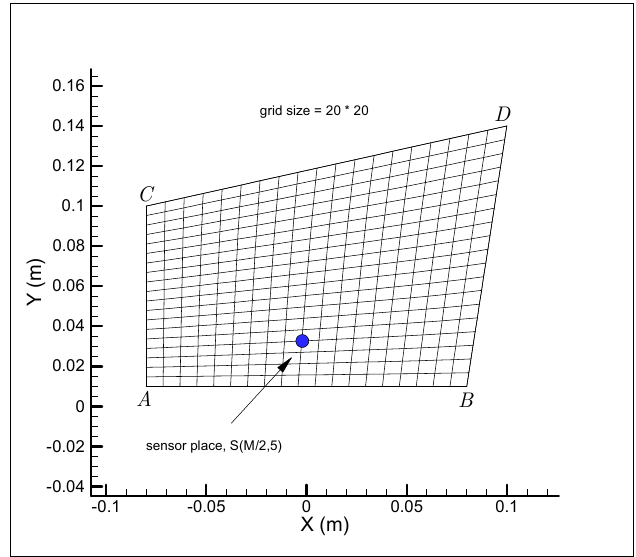
M ( M ,5 ) , used to measure the temperature at time t i S , used to measure the temperature at time 2